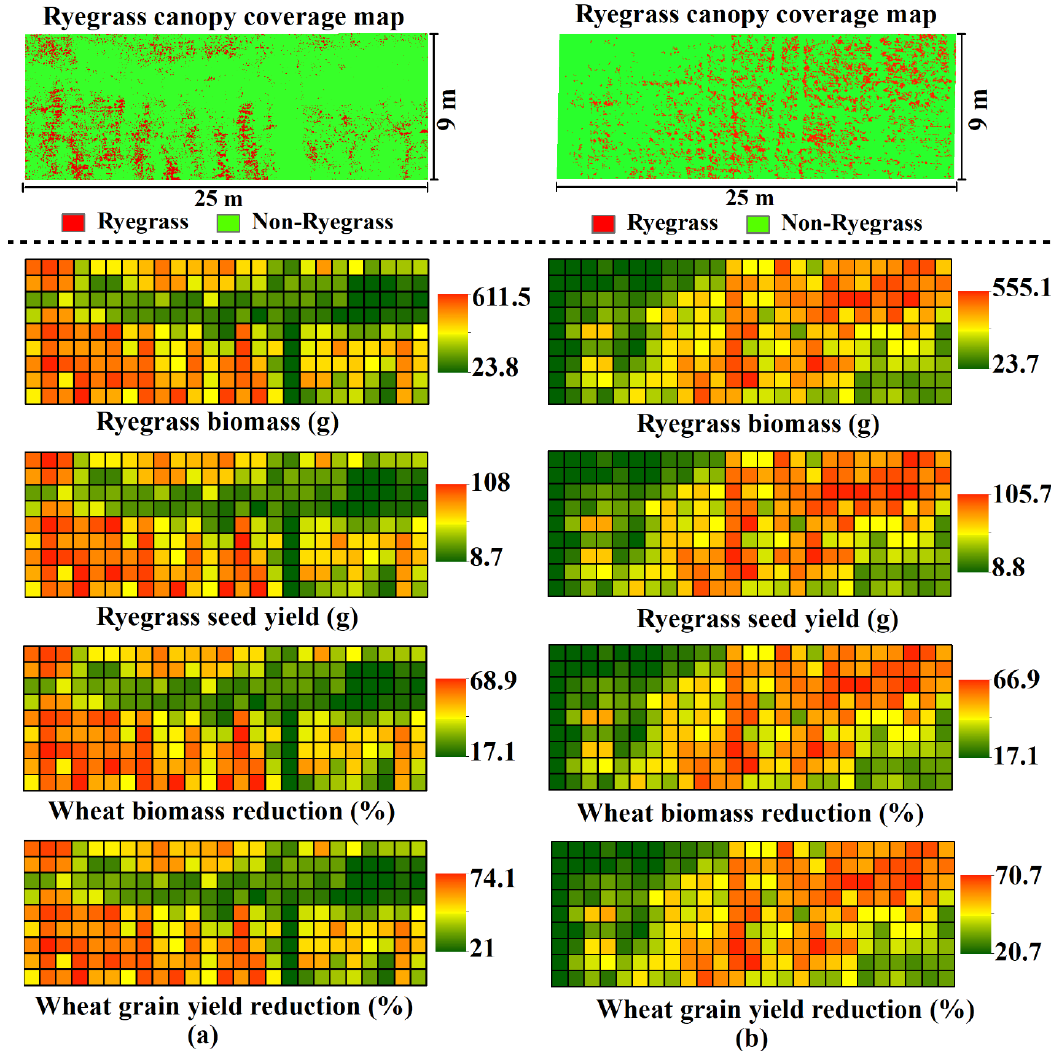
Figure 8. Implementation of predictive models over two validation sites ( a , b ). Predictions were done on 1 m × 1 m spatial grids created over the ryegrass canopy coverage map developed during early season (layers above the dashed line in the figure). The maps below the dashed line show the gradient of model predicted end-of-season estimates for different variables in each 1 m × 1 m grid.